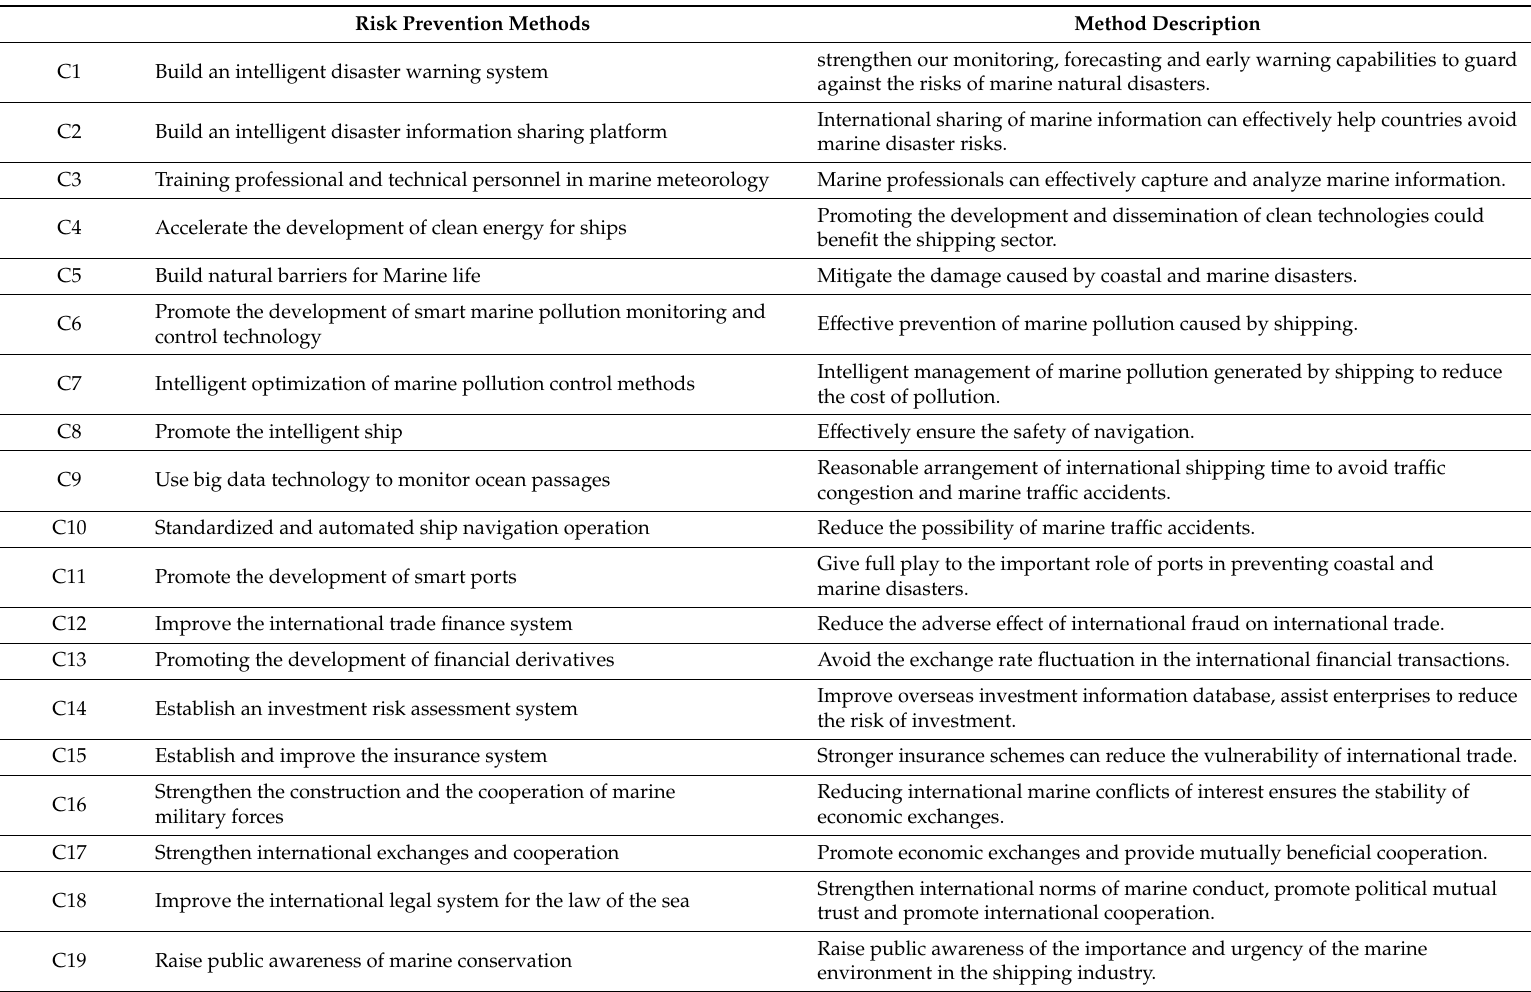
Table 2. Marine Silk Road risk smart prevention